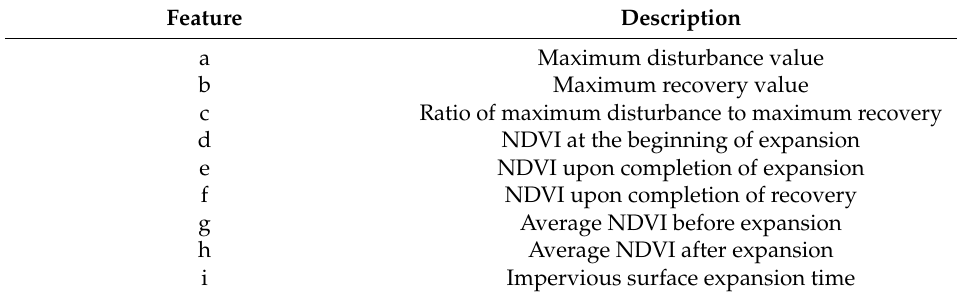
Table 2. Parameters representing the time series features of impervious surface expansion.